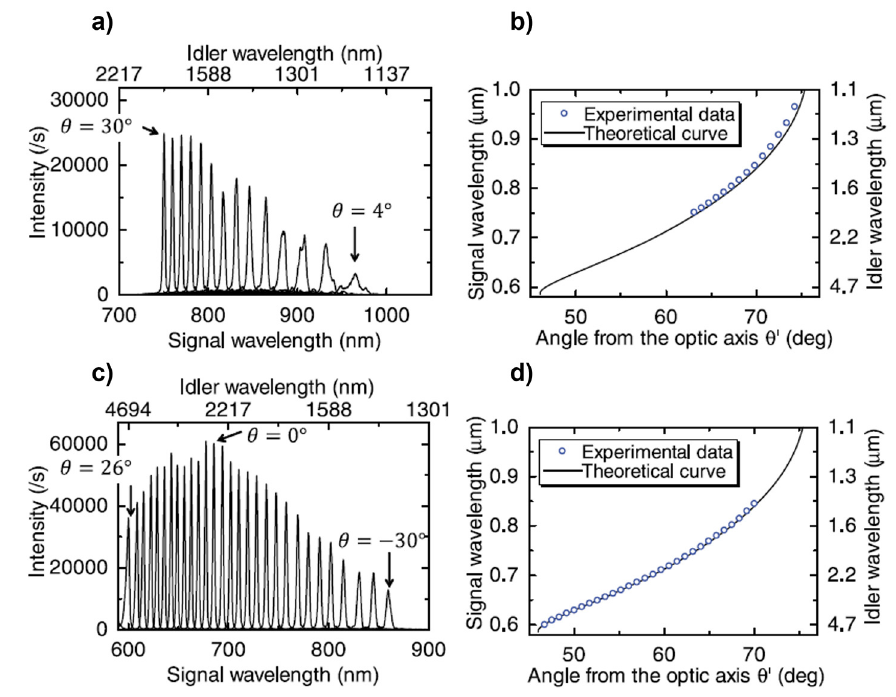
Figure 14. Spectra of SPDC signal photons generated from ( a ) crystal 1 varying the rotation angle θ from 4 ◦ to 30 ◦ every 2 ◦ and ( c ) crystal 2 varying the rotation angle from − 30 ◦ to 26 ◦ every 2 ◦ . The corresponding wavelengths of the idler photons are shown in the top axes. Signal center wavelength as a function of the internal angle θ ’ for crystal 1 ( b ) and crystal 2 ( d ). The right axes show the corresponding wavelengths of the idler photons. Reproduced with permission from [60], copyright